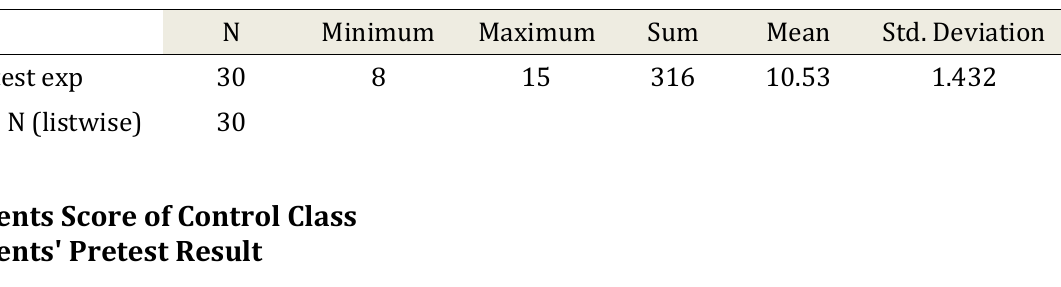
Table 4.17 The Score of Students' Pretest Result in Control